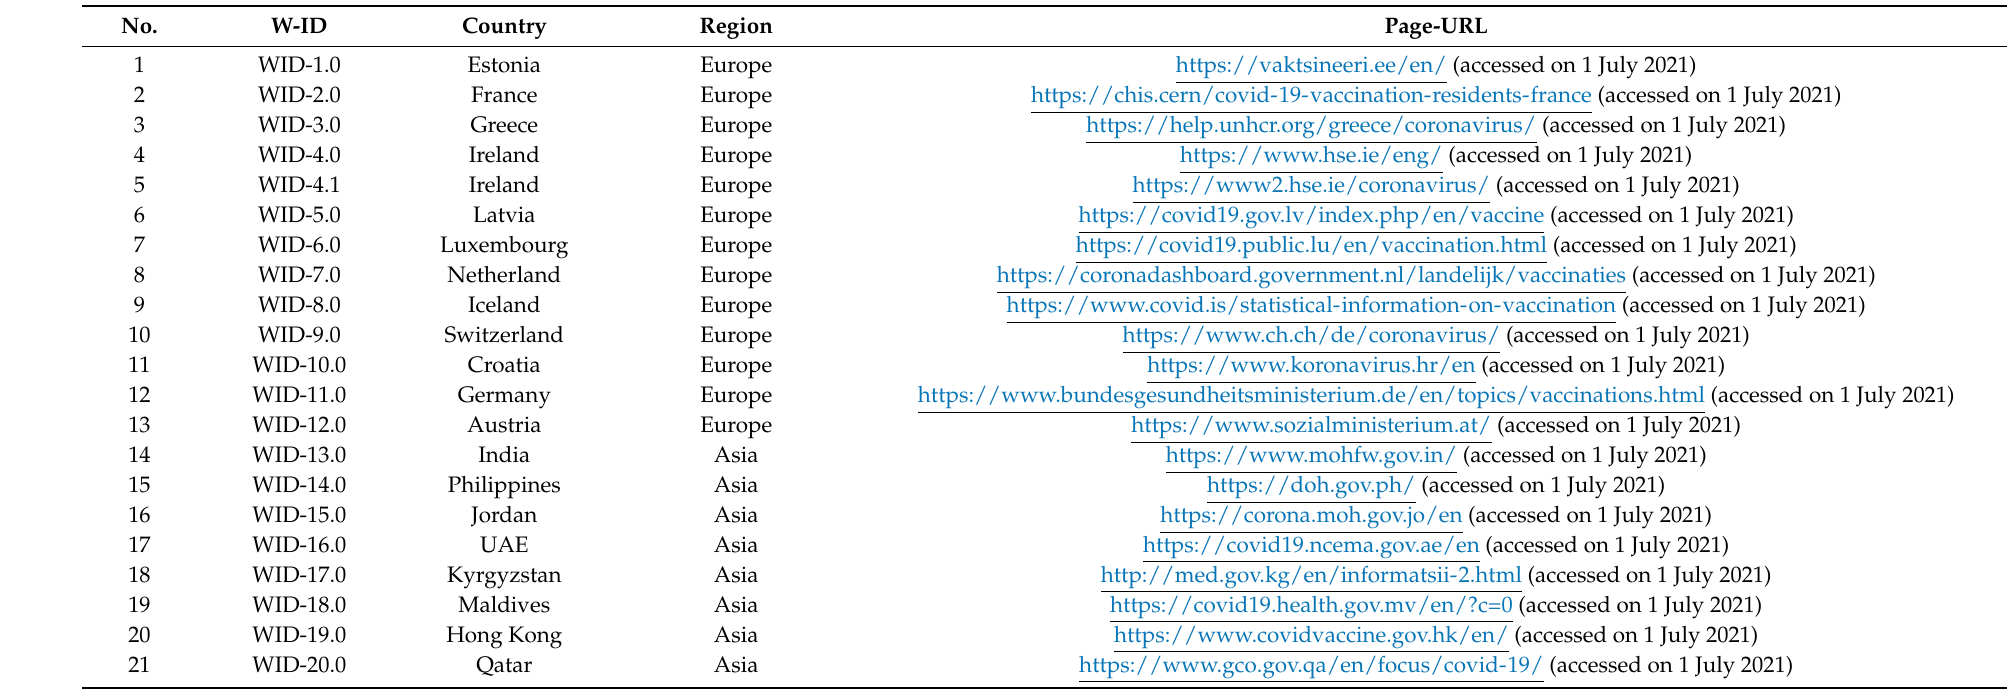
Table 1. Considered selective Government